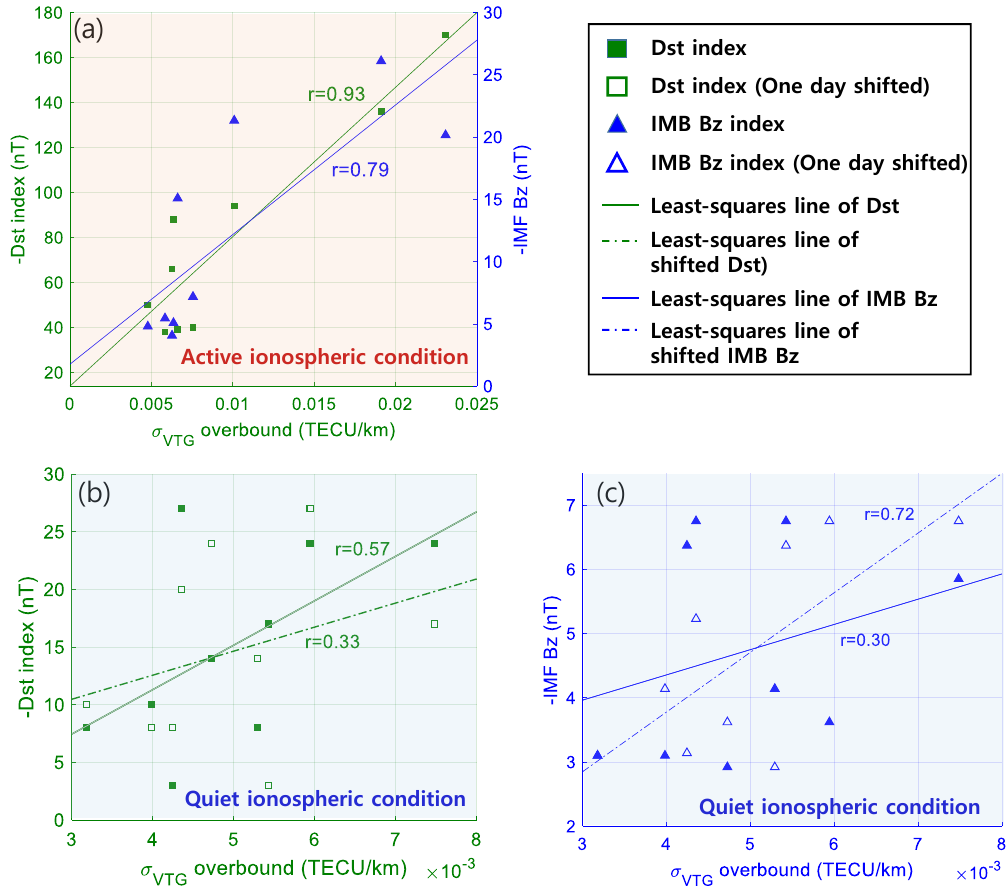
Figure 6. Pearson’s correlation coefficients determined for active ionospheric conditions using Dst and IMF Bz ( a ), and for quiet conditions using Dst index ( b ) and IMF Bz index ( c ).